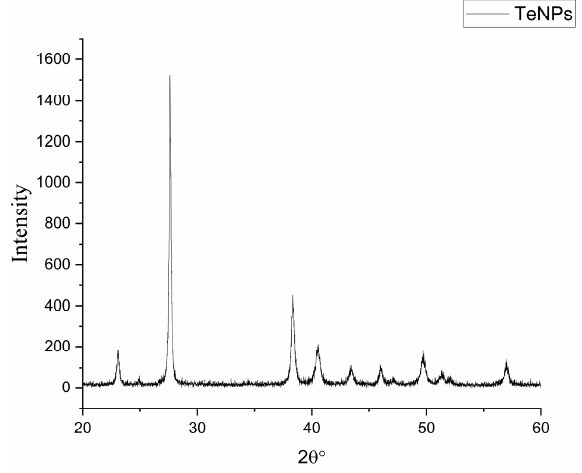
Figure 6. XRD spectrum of the biogenic TeNPs produced by Gayadomonas sp. TNPM15.